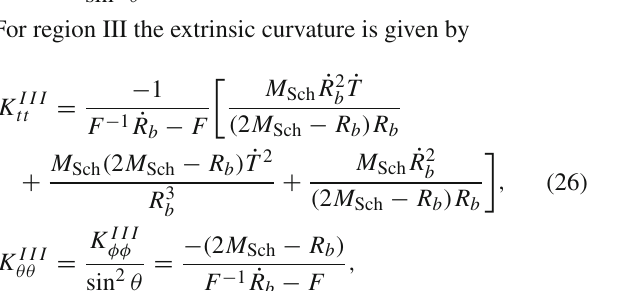
/ 2 = M M eff Sch at all times. The Ib I